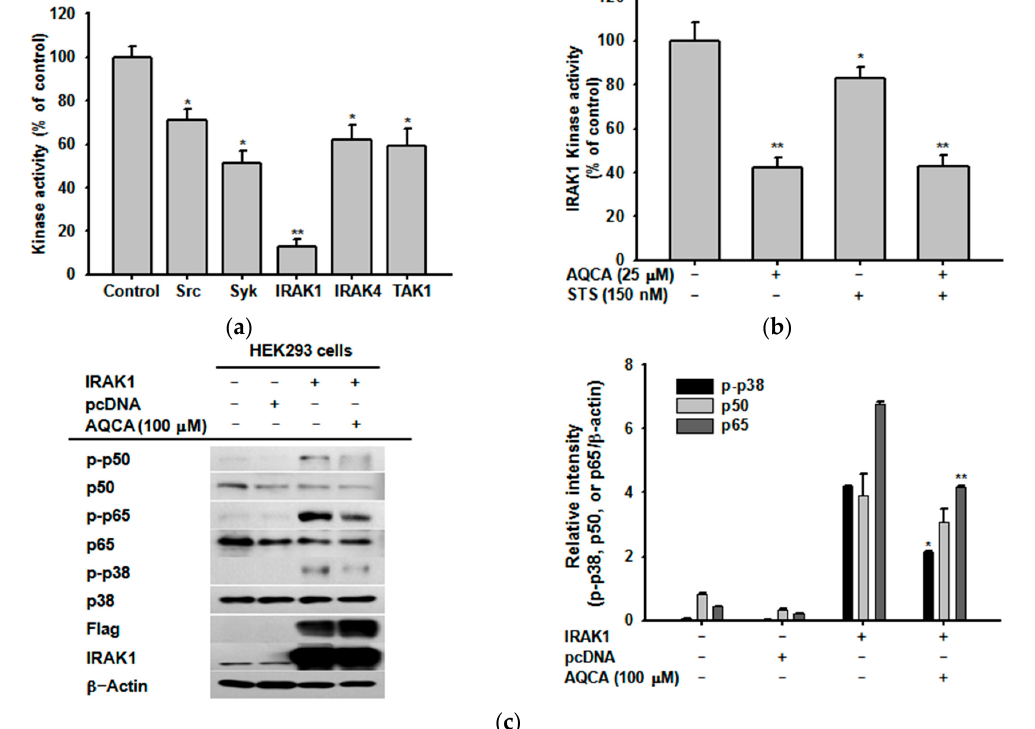
Figure 4. Effect of AQCA on IRAK1 enzyme activity. ( a , b ) the inhibitory effect of AQCA (50 μ M) or staurosporin (STS) (150 nM) on the enzyme activity of Src, Syk, IRAK1, IRAK4, or TAK1 was determined using a conventional kinase assay with purified enzymes provided from Millipore (Billerica, MA, USA). The control was set as 100% activity for each enzyme with vehicle treatment only. ( c left panel) HEK293 cells transfected with IRAK1 (1 μ g/mL) for 36 h were treated with AQCA (100 μ M) for 12 h. The levels of total or phosphorylated p50, p65, p38, IRAK1, Flag, and β -actin in whole cell lysates were identified using immunoblot analyses. Relative intensity ( c right panel) was calculated relative to β -actin levels using the DNR Bio-Imaging system. All data ( a – c left panel) are expressed as the mean ± SD of experiments performed with three samples. * p < 0.05 and ** p < 0.01 compared to the control (purified enzyme alone or Flag-IRAK1 alone) groups.